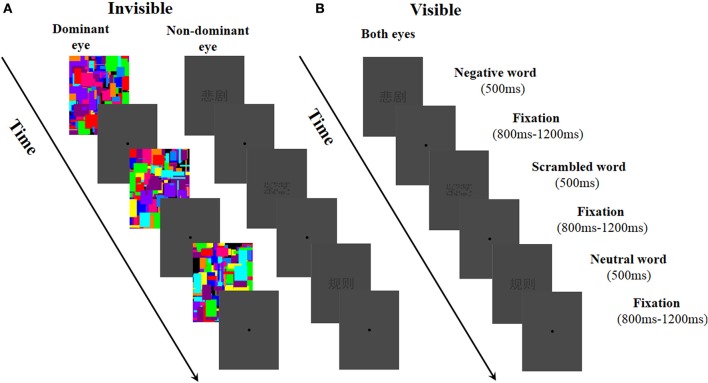
Experimental procedure used in this study. (A) In the invisible condition, Mondrian-style images were presented to the dominant eye at a rate of 20 Hz while negative, neutral, and scrambled words were randomly presented to the non-dominant eye. (B) In the visible condition, negative, neutral, and scrambled words were randomly presented to both of the participant's eyes.